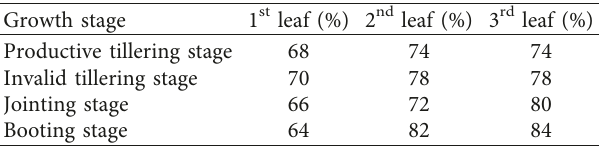
Table 7: Validation accuracies of the diagnosis model for rice K